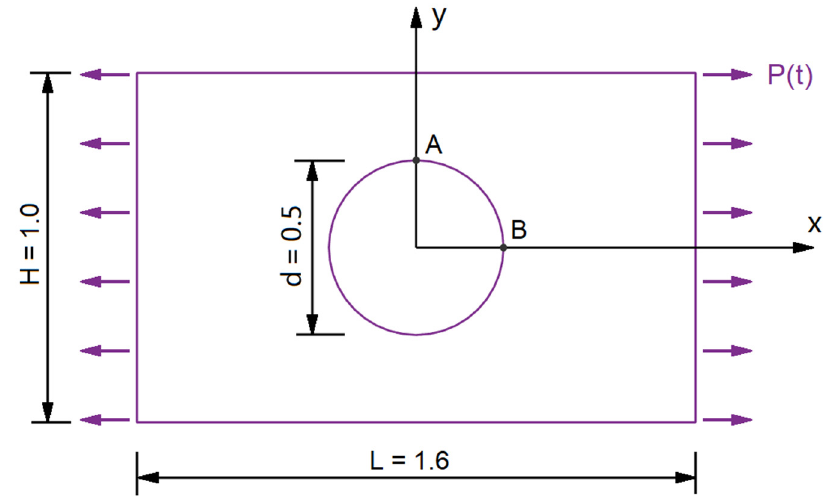
Figure 29. A perforated tension strip subjected to a Heaviside tension step loading.